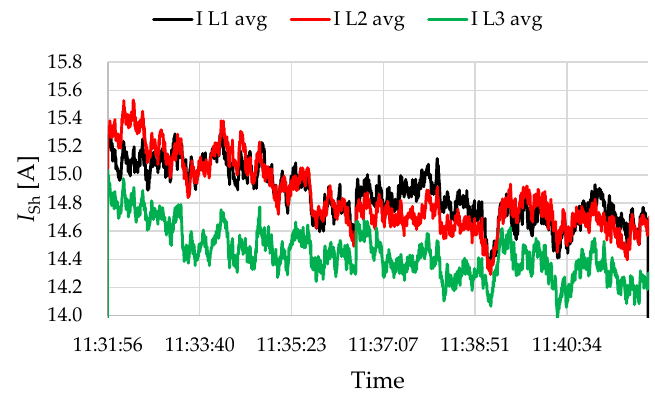
Figure 12. Sheaths currents measured in Substation 2. Sheaths unearthed and uncrossed (Sh2). Operation only with the analyzed line.